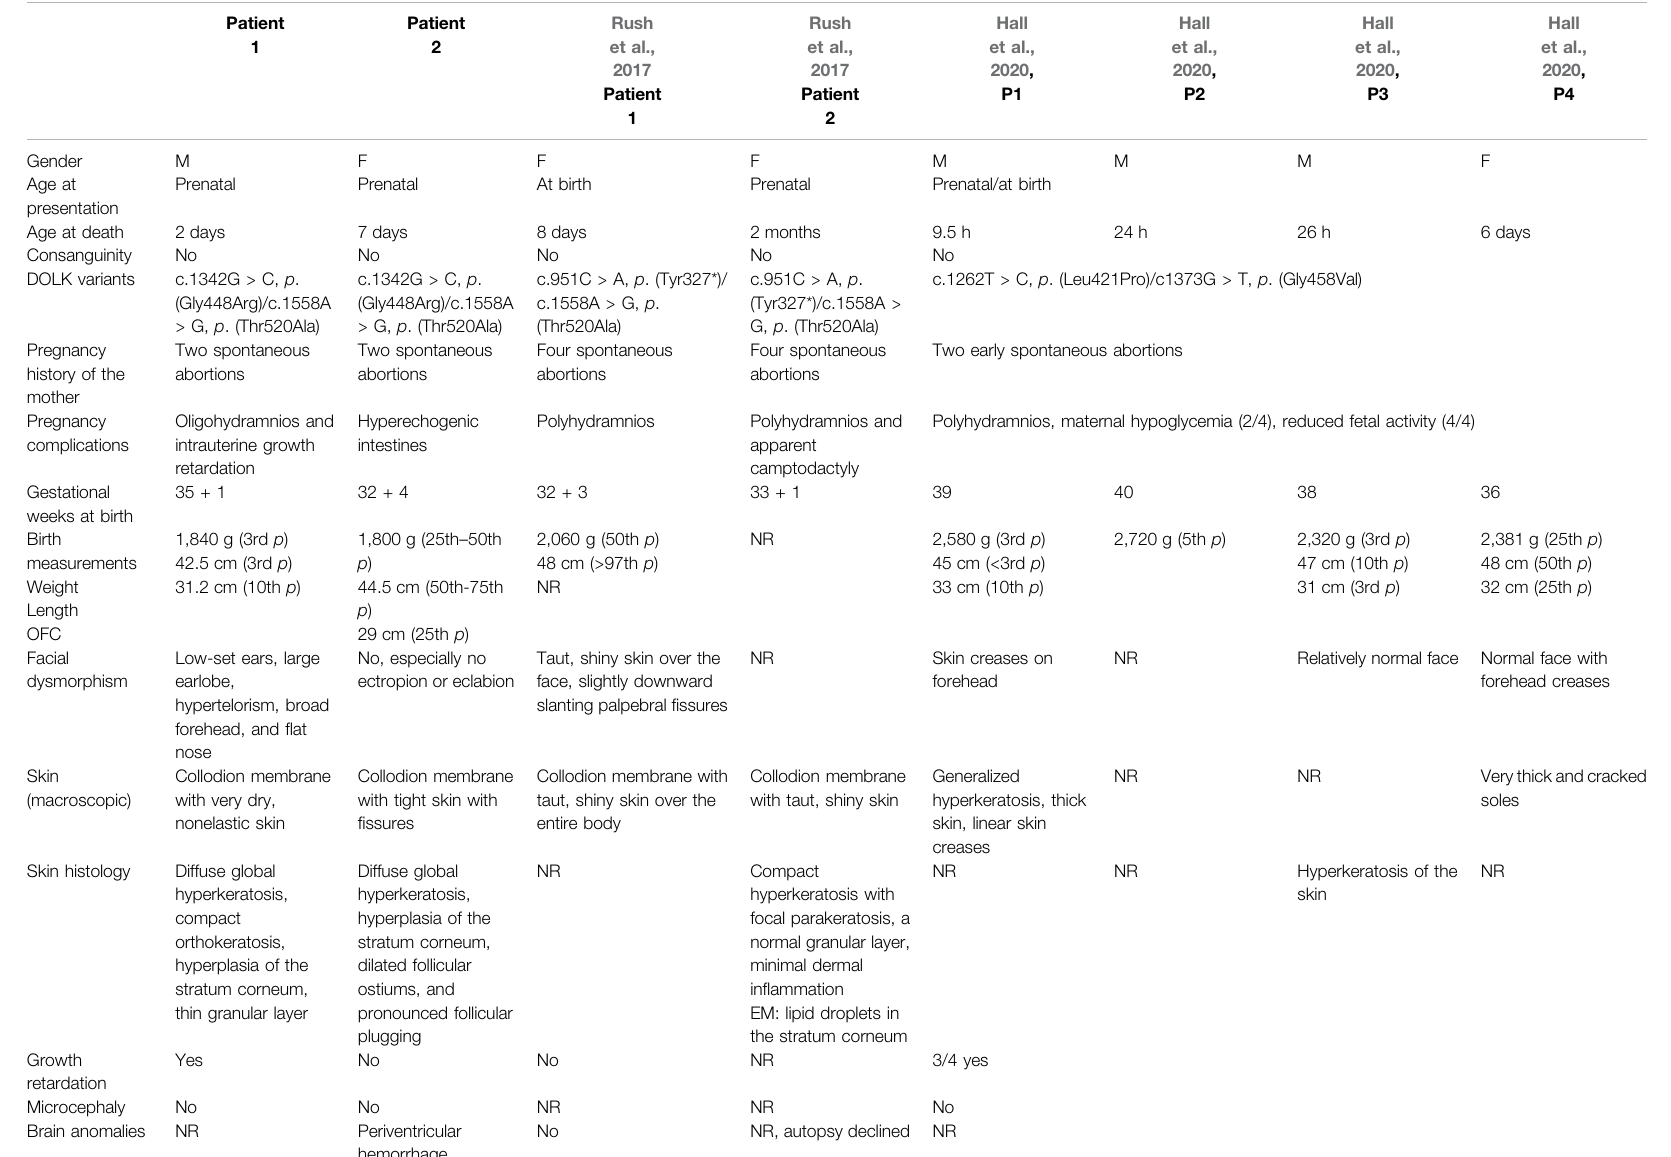
TABLE 1 | Clinical and laboratory comparison of eight DOLK-CDG cases with fatal neonatal or early infantile